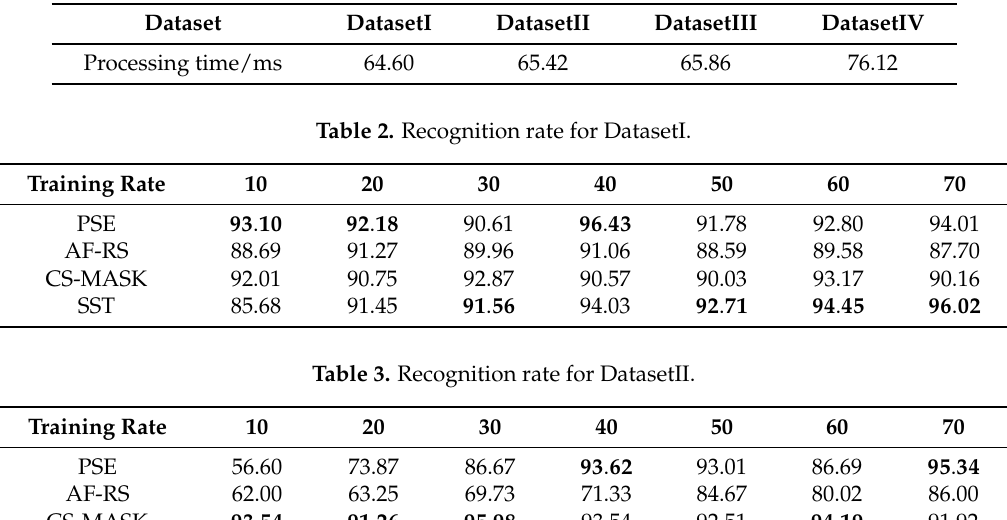
Table 1. Processing time for each dataset.